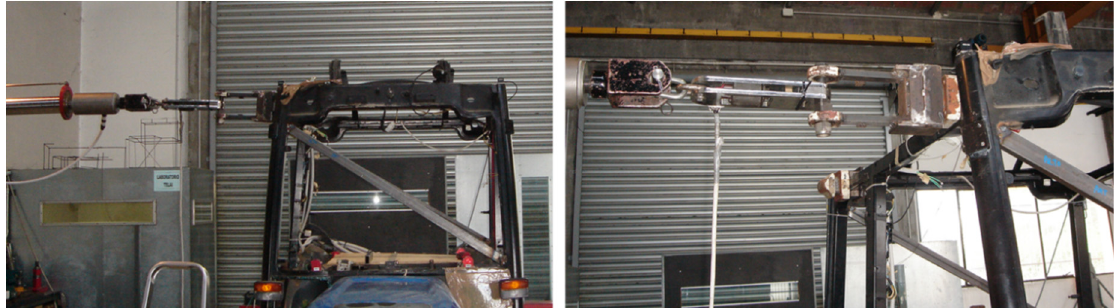
Figure 5. Dynamic test set-up showing tensile loading of the C2 load cell using the magnetic pliers.